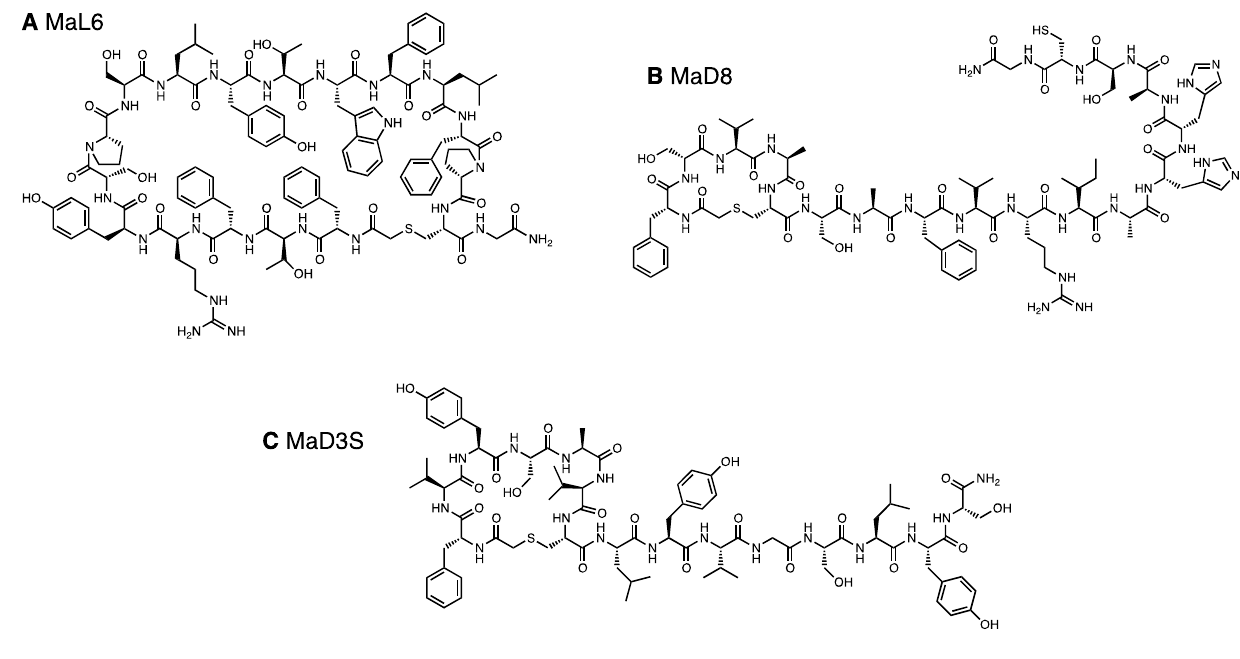
Figure 1. Chemical structure of in vitro selected macrocyclic peptides that bind to PfMATE. ( A ) MaL6, ( B ) MaD8, and ( C )